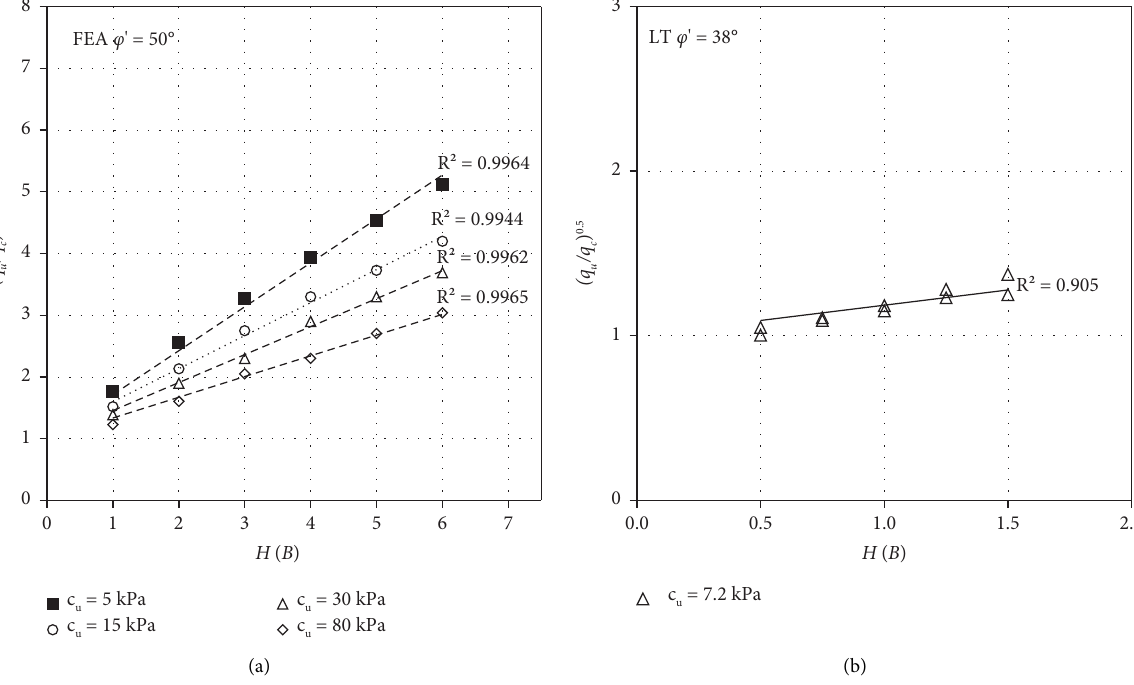
Figure 10: ( q q ) 0 . 5 versus H/B for geogrid-stabilised granular layer (data source: (a) Lees and Matthias [39] and (b) Roy and Deb [40]): (a) u / c FEA ϕ ′ � 50 ° and (b) LT ϕ ′ � 38 °